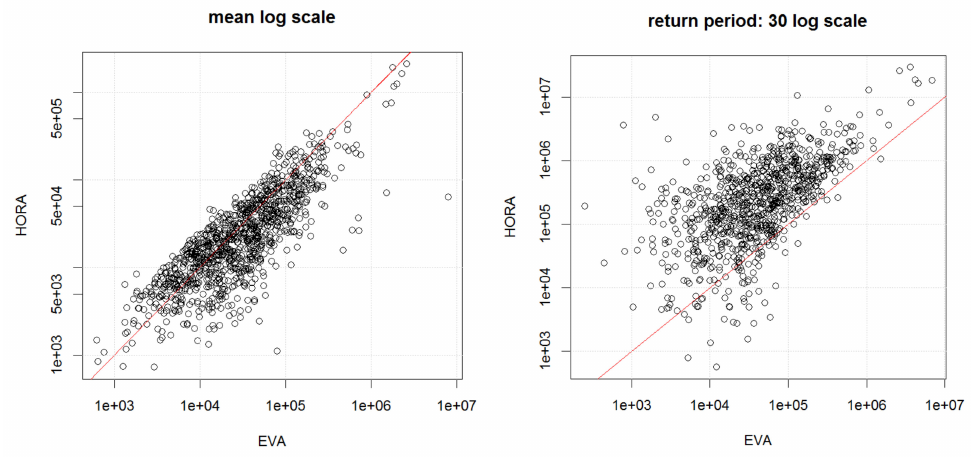
Figure A10. Scatterplot of the expected yearly damage ( left ) and of the 30-year return period level ( right ) for all municipalities for the HORA method and the EVA